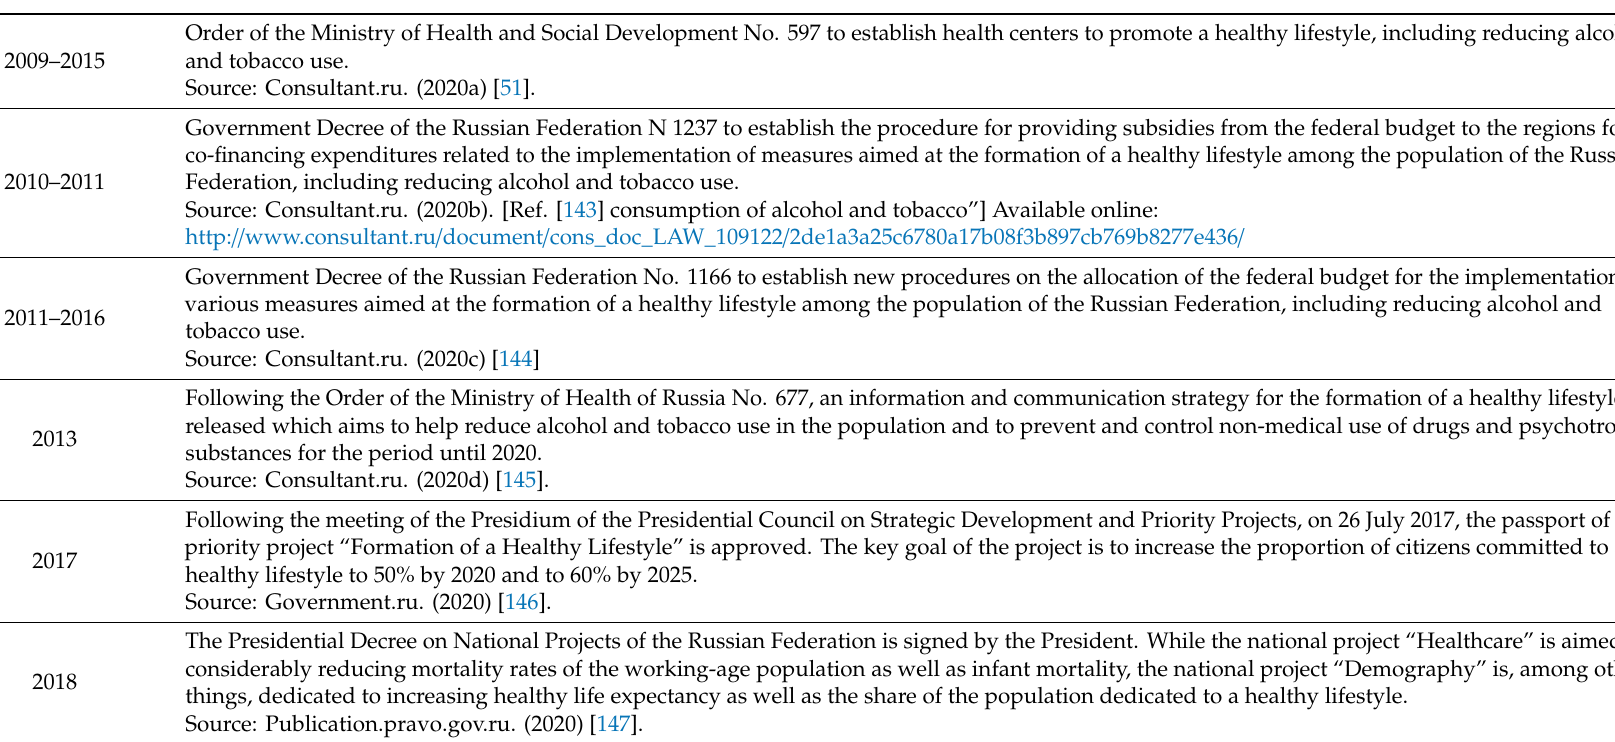
Table A2. Overview of legislation introduced since 2009 that aim at reducing alcohol consumption and / or increasing physical activity at the population level as part of a healthy lifestyle promotion